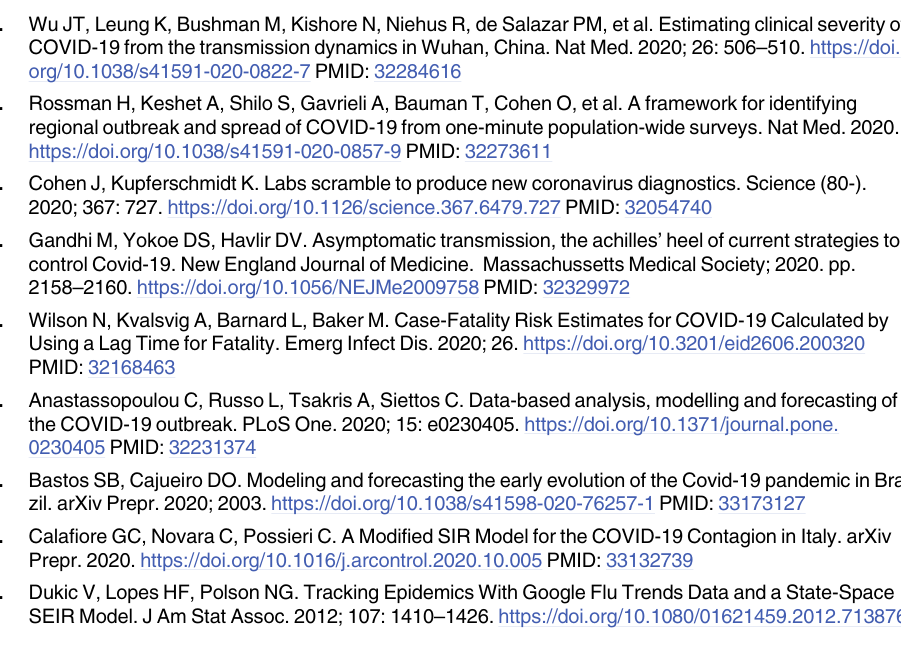
and R . eff hat by policy p ipt